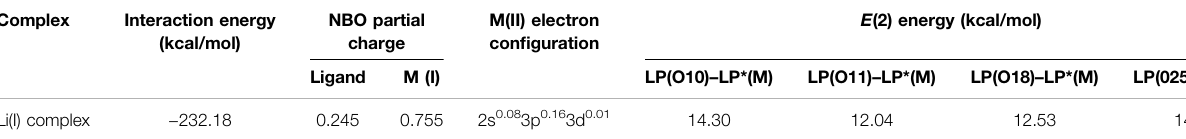
TABLE 5 | The calculated parameters for the complex.